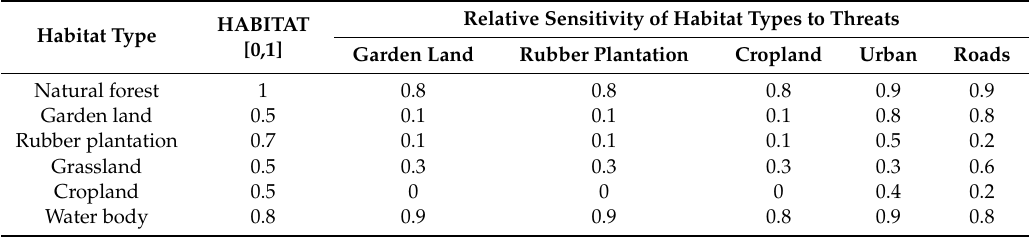
Table 2. Mean value for habitat suitability (HABITAT) and relative sensitivity of habitat types to threats.